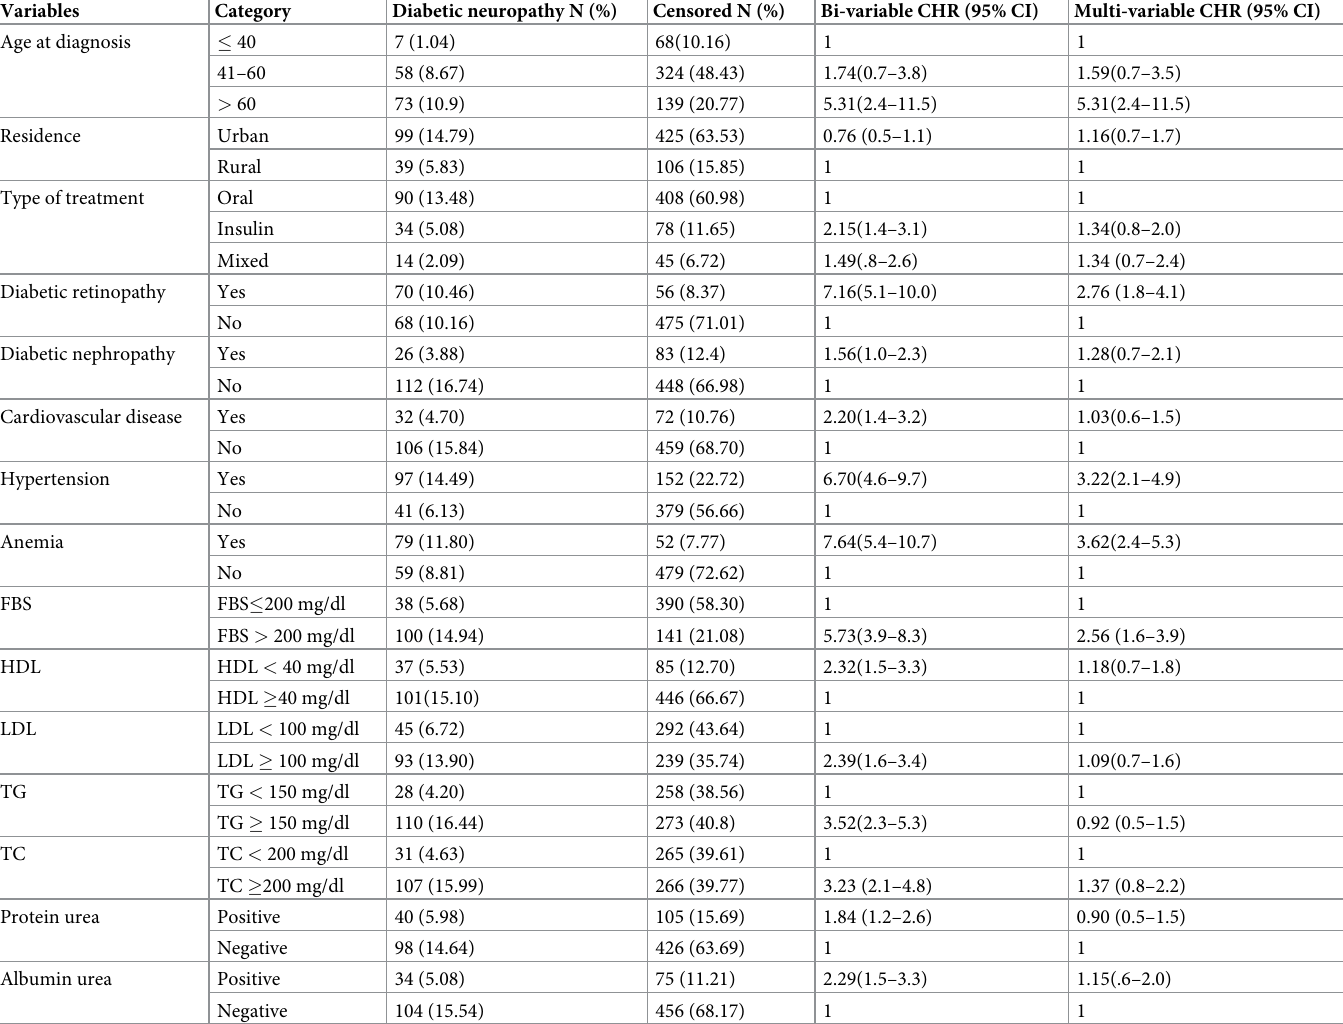
Table 5. Result of the bi-variable and multi-variable cox regression analysis of adult T2DM in Amhara region compressive specialized hospital Northwest Ethiopia, 2022 (n =